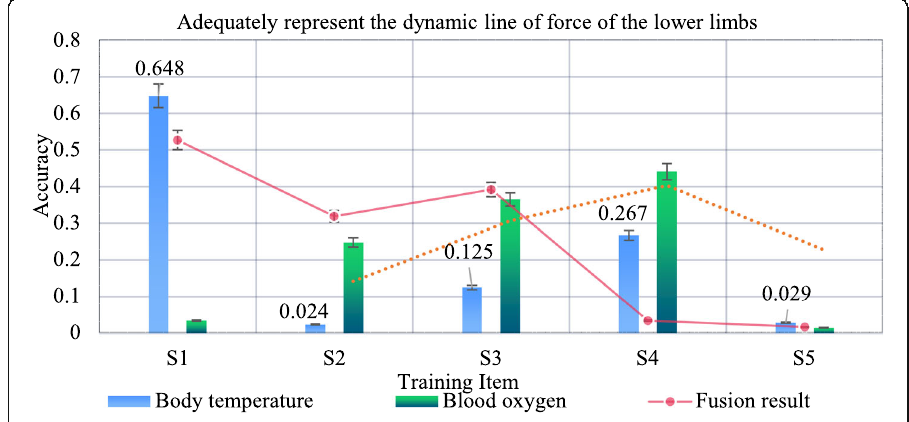
Fig. 1 Body detection system result